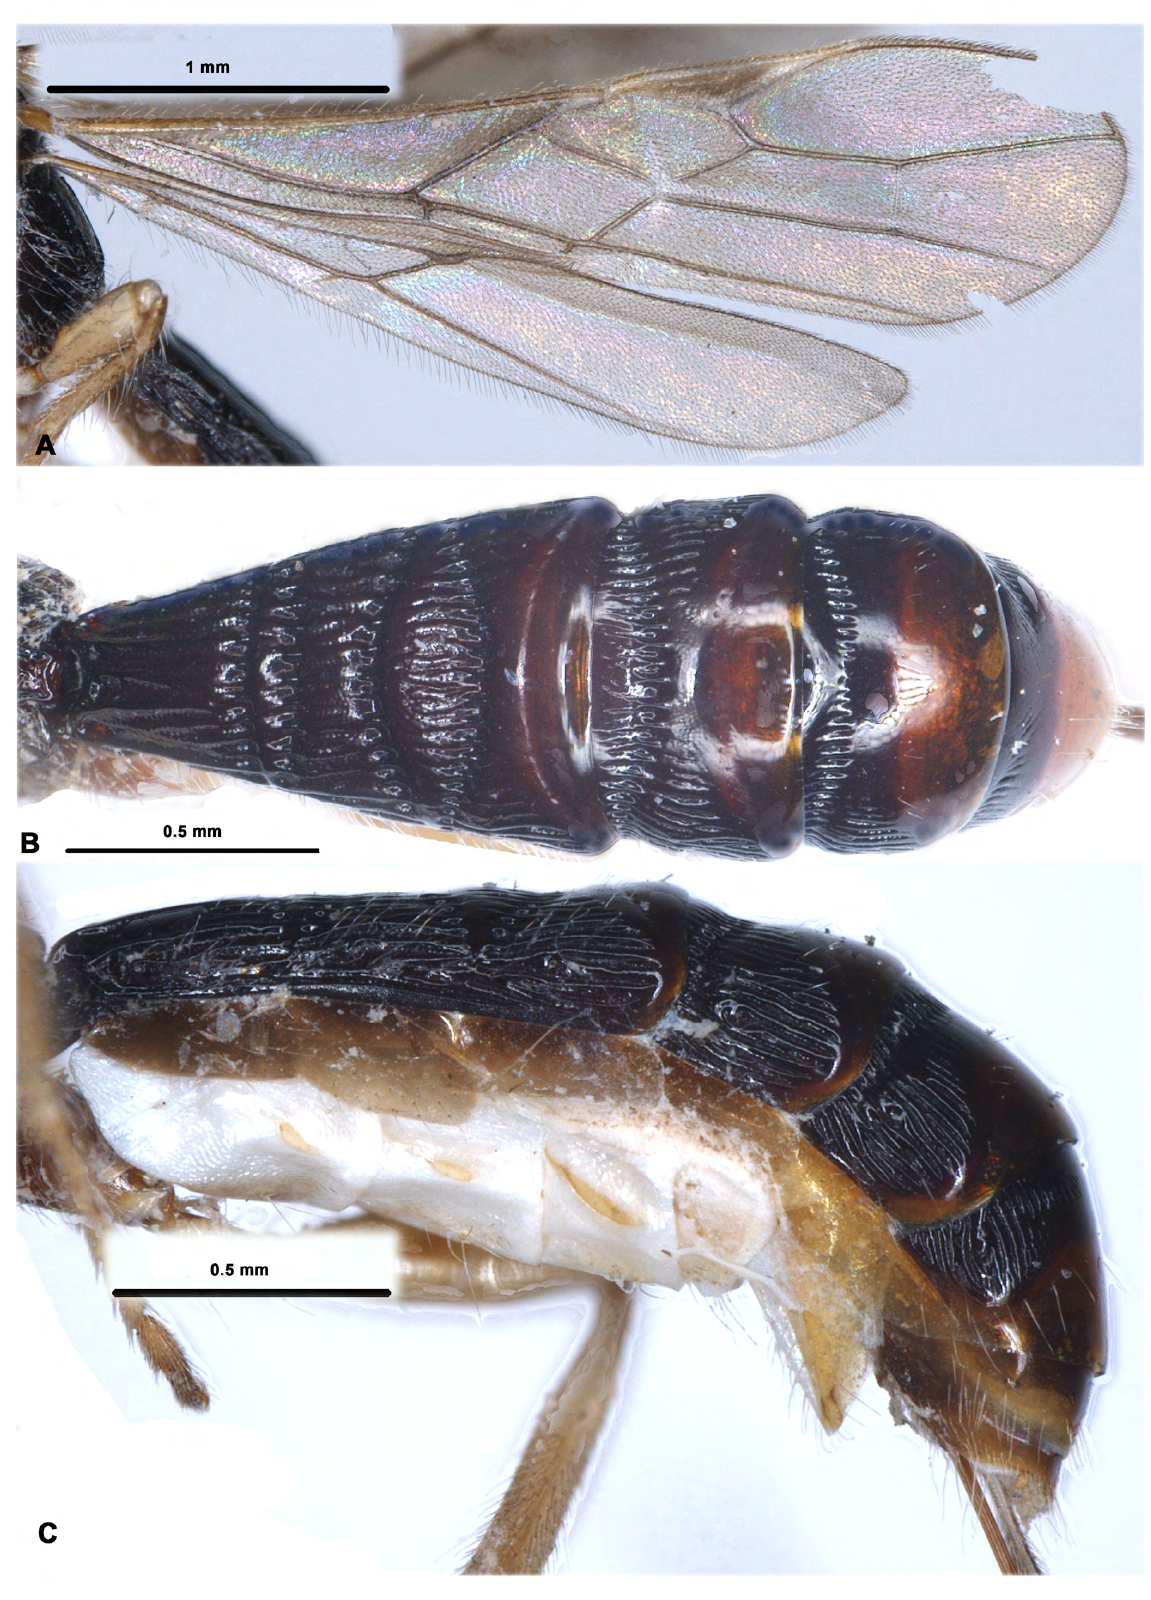
Fig. 4. Arhaconotus papuanus Belokobylskij, 2000, ♀, holotype, TAMU. A . Wings. B . Metasoma, dorsal view. C . Metasoma, lateral